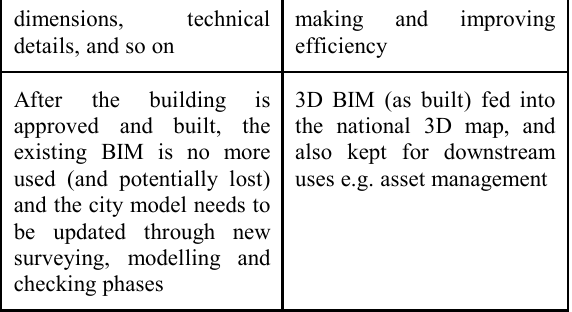
Table 1. GeoBIM Links into High Level